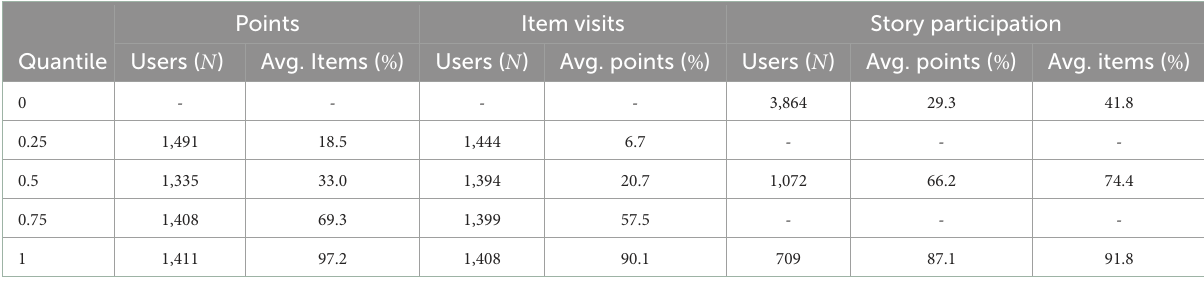
TABLE 5 Quantiles for percentage of points and item visits compared to story participation in the java2020 course (Hagedorn et al., 2022). Points Item visits Story participation Quantile Users ( N